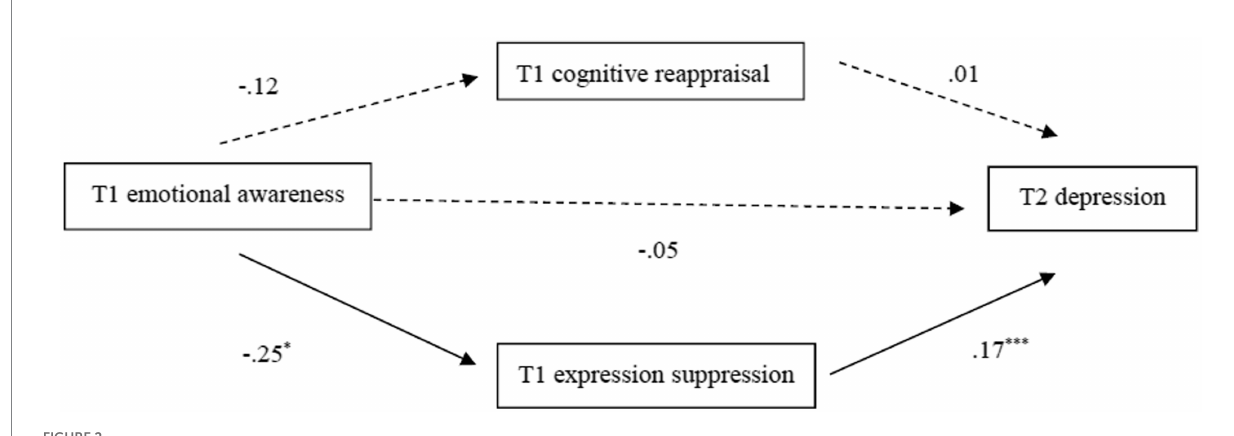
FIGURE 2 Mediating model for emotion regulation strategies between T1 emotion awareness and T2 depression. Straight lines represent the coefficient is significant. Dashed lines represent the coefficient is not significant. The coefficient from emotional awareness to depression below the center horizontal path represents the direct effect. * p < 0.05, *** p <